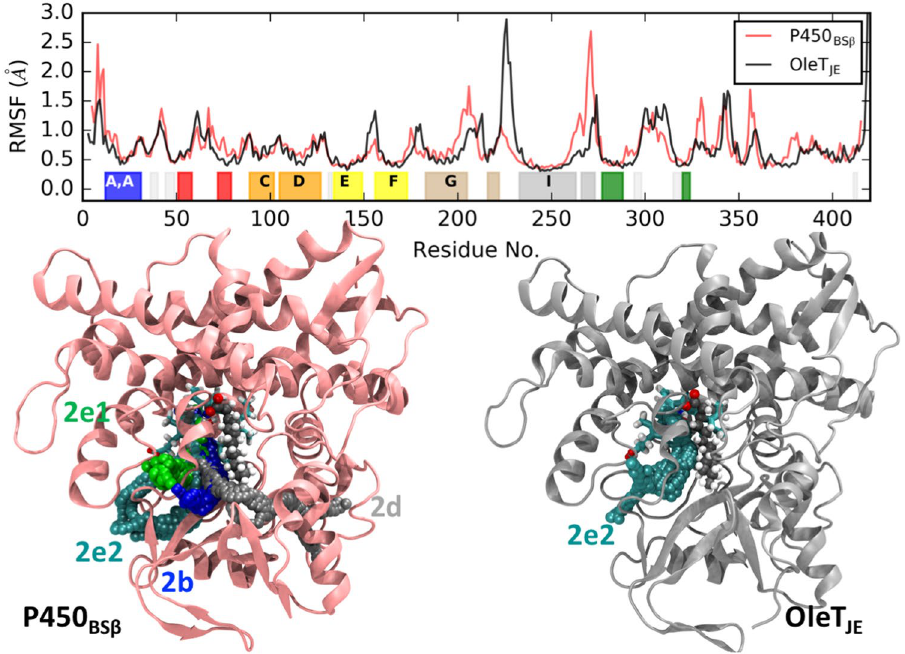
Figure 3. Enzyme dynamics in the intermediate state (compound II and substrate radical): (Top) Root Mean Square Fluctuations (RMSFs) enable comparisons of flexible regions in P450 BS β and OleT JE . The important structural domains of the protein are highlighted and correspond to the color-coded domains depicted in Fig. 1. (Bottom: Left and Right) CAVER analysis reveals dominant protein channels connecting the enzyme surface to the active site in P450 BS β (Left) and OleT JE